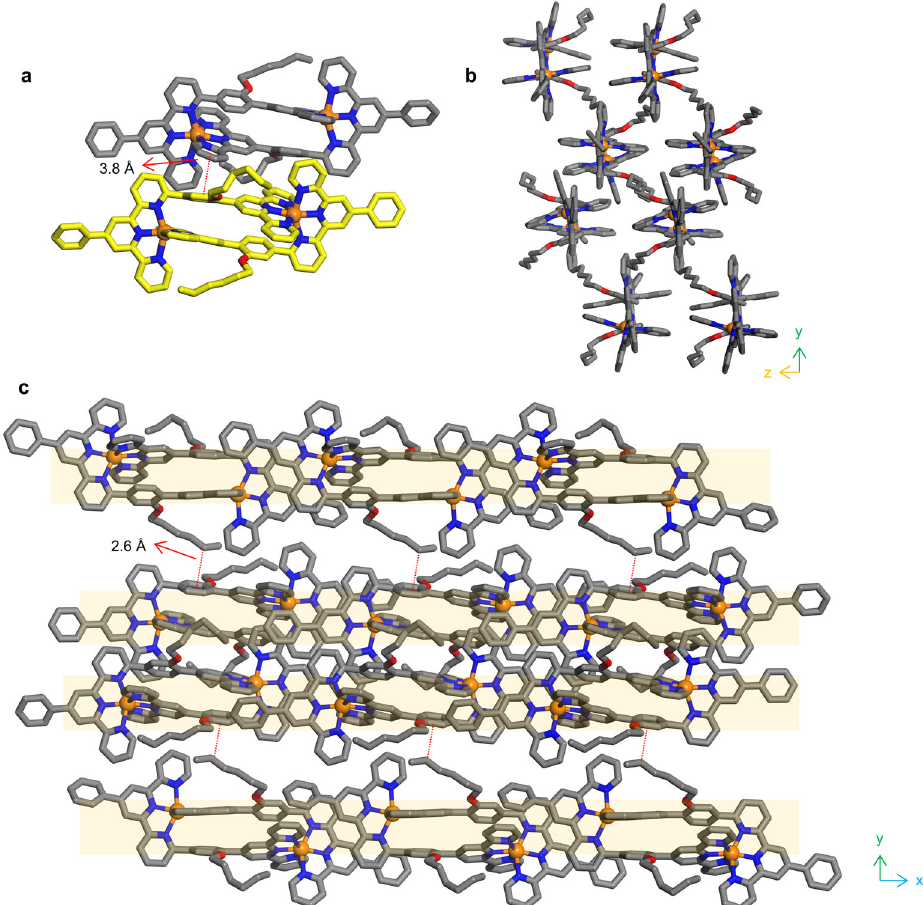
Fig. 7 Crystallographic structure of complex Zn 2 (MA-OC 6 H 13 ) 2 . a Crystal packing of two complexes Zn 2 (MA-OC 6 H 13 ) 2 . b Crystal packing structure in a side view of complex